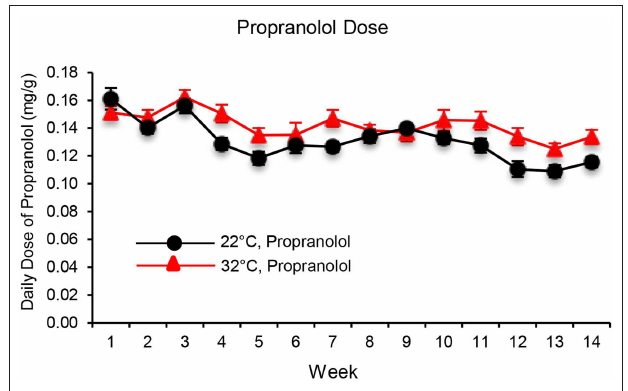
FIGURE 1 | The daily dose of propranolol—administered in drinking water—in mice housed at room temperature (22 ◦ C) and thermoneutral temperature (32 ◦ C) over the 14-week duration of study. Data are mean ± SE. N =